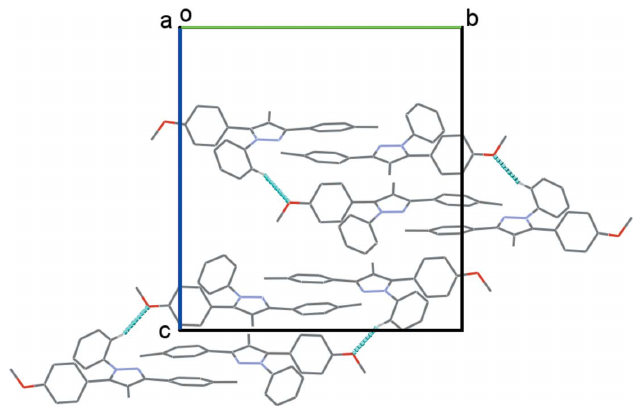
Figure 2 A partial packing diagram of the title compound viewed down the a axis, showing the C—H (cid:3)(cid:3)(cid:3) O hydrogen bonds as blue lines.